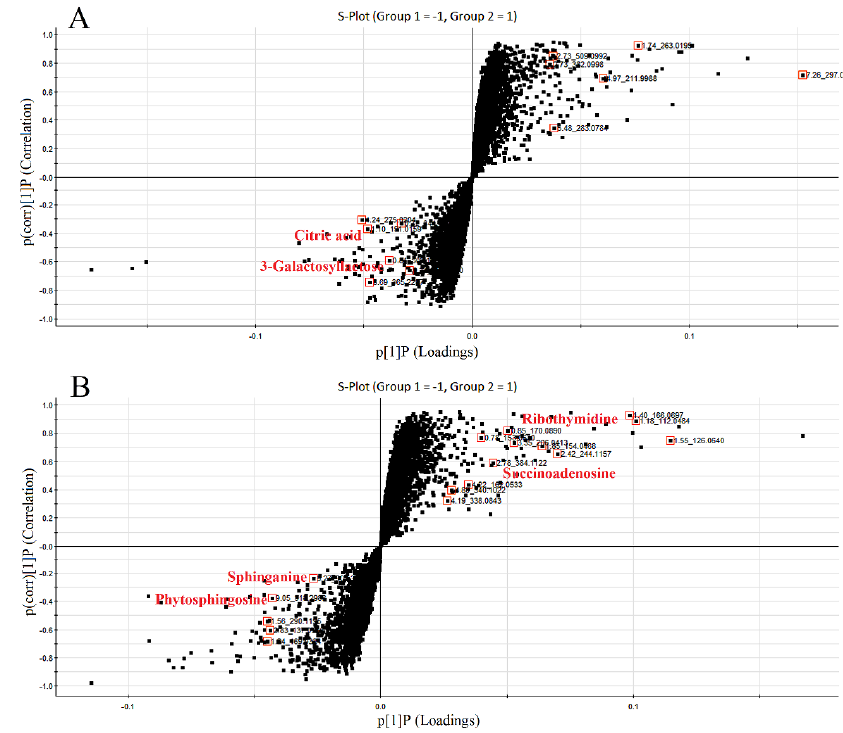
Figure 4. S-plots of the metabolome in rat urine from the control and model groups (( A ), negative mode; ( B ), positive mode). The loading S-plot represents the impact of the metabolites on the clustering results. The S-plot of the OPLS-DA showed variables positively correlated with score plots. Statistically significant differences in the six metabolites responsible for the discrimination of the groups were identified between the model and treated groups. Red data points indicate the ions most responsible for the variance in the score plot.